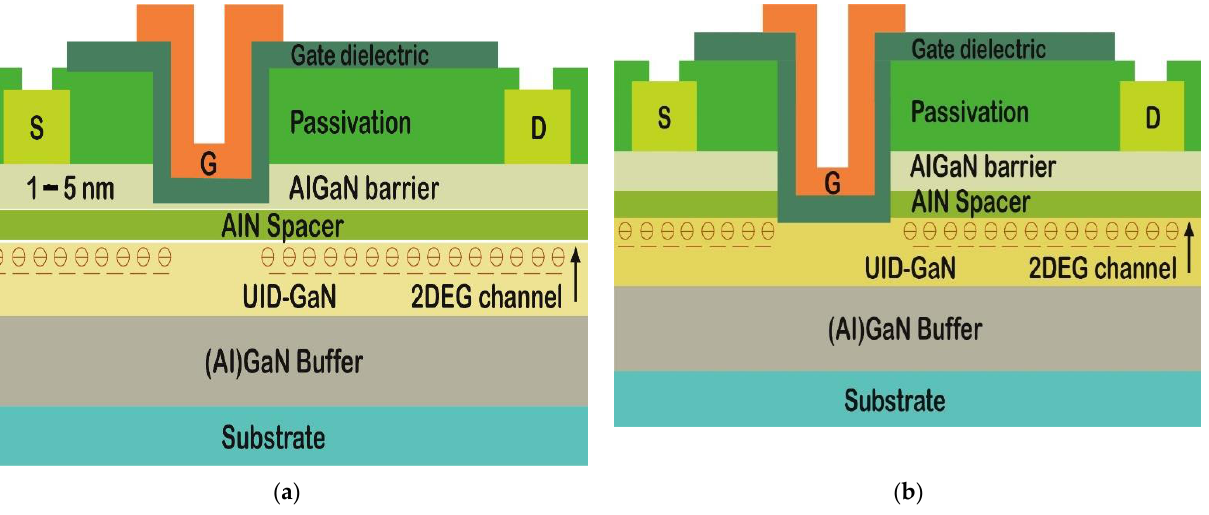
Figure 23. ( a ) Normally-off HEMTs with slight MIS-HEMT of recessed-gate design; ( b ) normally-off HEMTs with complete MIS-FET of recessed-gate